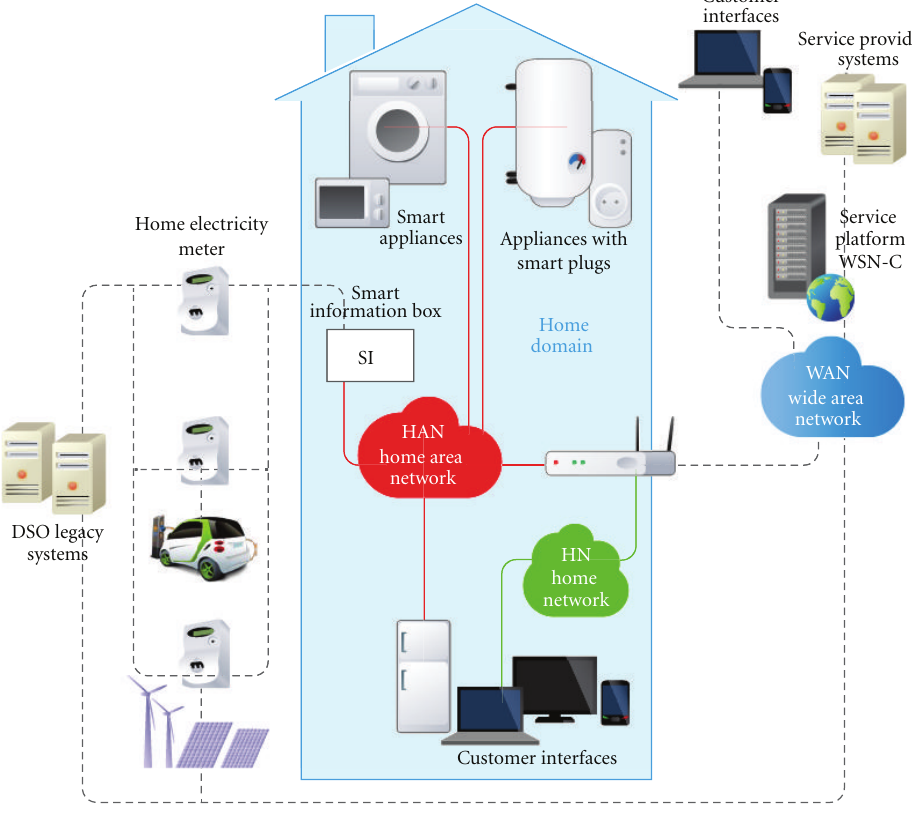
Figure 6: Smart energy HAN general